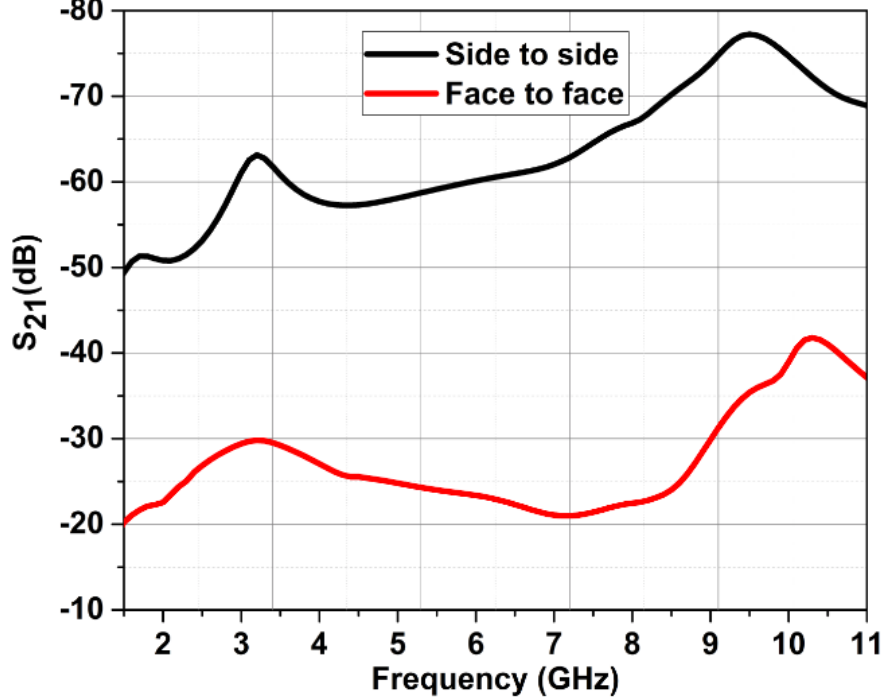
Figure 16. Isolation characteristics of the UWB antenna.